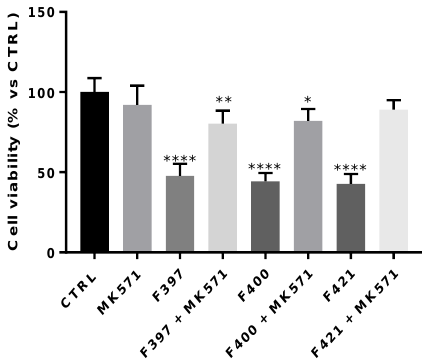
Figure 3. Cell viability of F397, F400, and F421 at 10  M alone and with MK571 at 25  M on the A549/DX cell line. Each bar represents the mean ± SEM of three experiments performed in